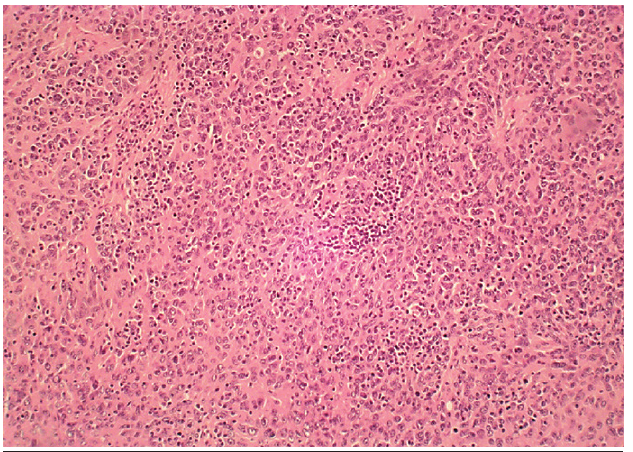
FIguRE 2 − FDCS Sheets of epithelioid cells with eosinophilic cytoplasm. FDCS: follicular dendritic cell sarcoma.